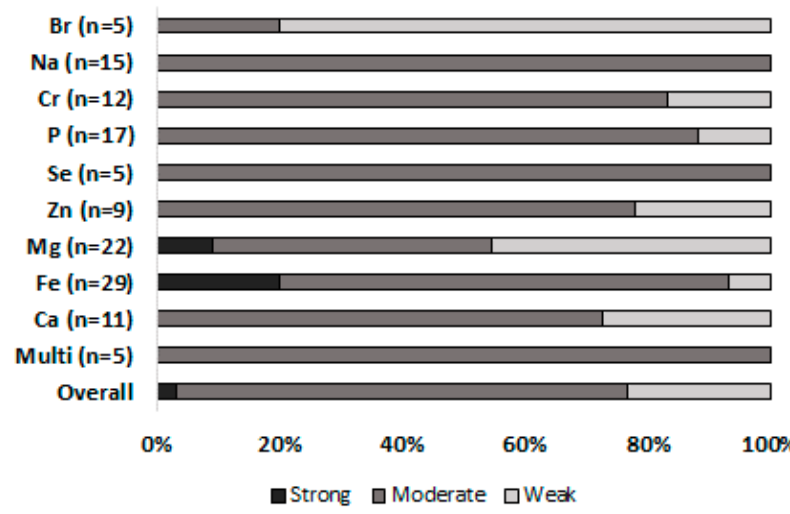
Figure 2. EPHPP global quality rating. Presented as percentage of articles rated as strong, moderate and weak for each mineral.